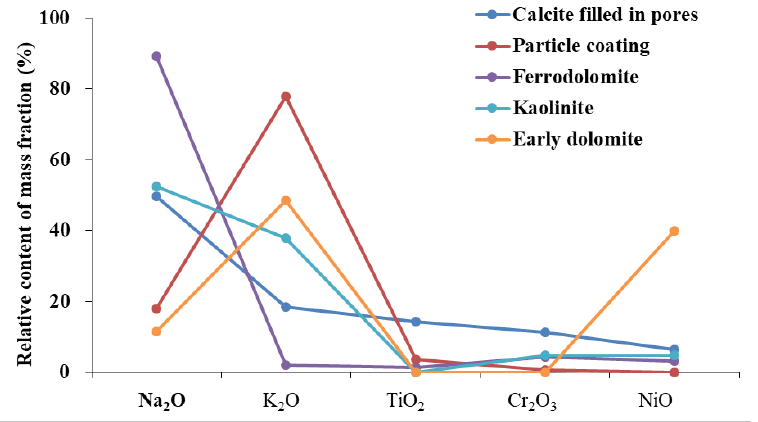
Figure 11. The partition patterns of some oxides of early dolomite and other